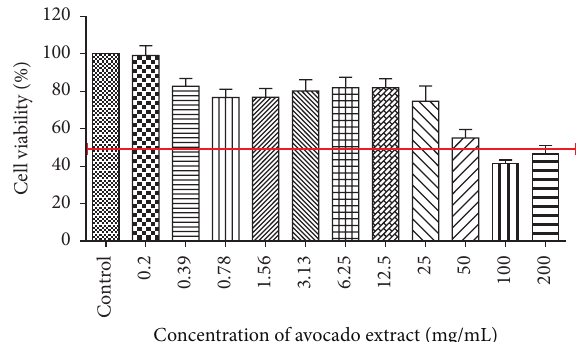
Figure 3: Cell viability of different concentrations of avocado comparing to control ( 𝑛 = 8